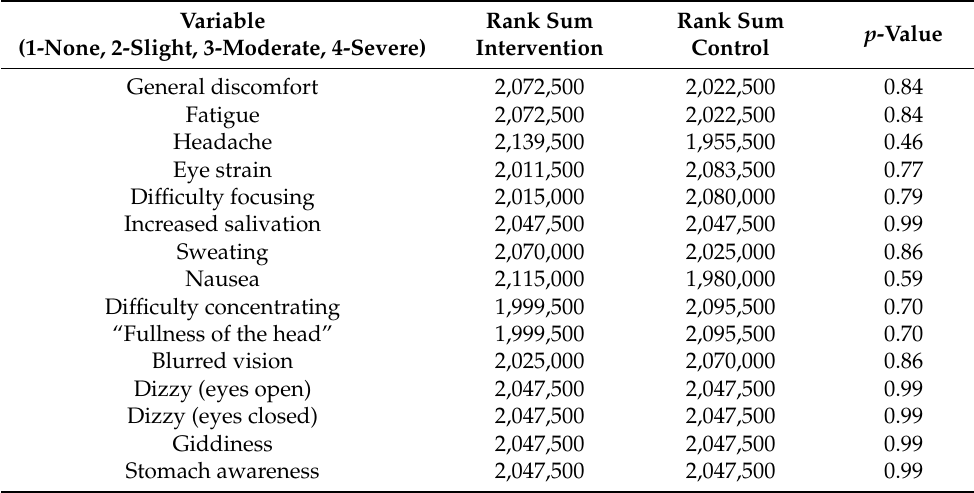
Table 6. The symptoms related to use of simulator questionnaire